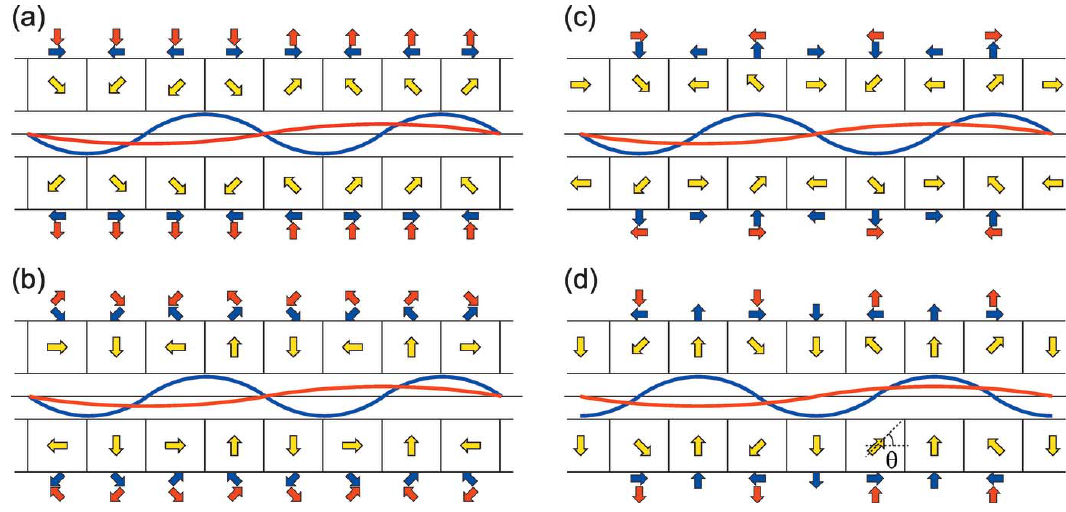
Figure 2 Four different undulator configurations to generate the composite period magnetic fields. Blue and red lines indicate the magnetic field distributions for the fundamental and double-period components,